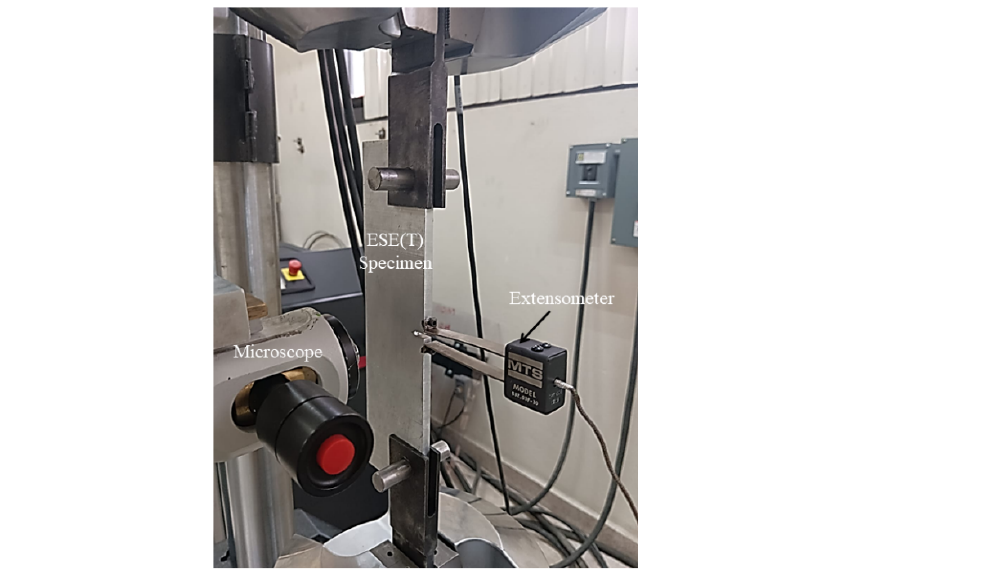
Figure 2. Experimental test setup for the crack propagation.